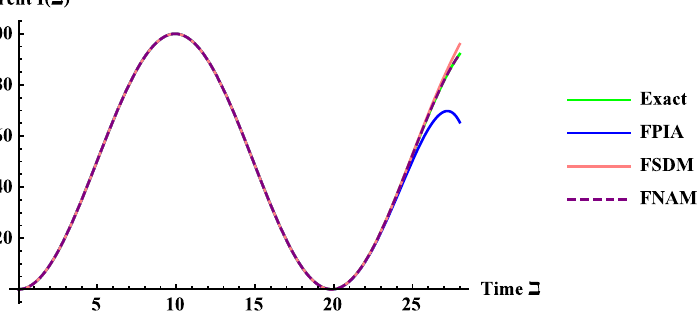
Figure 1. Graphical comparison of classical solution and approximate solutions of inductor–capacitor